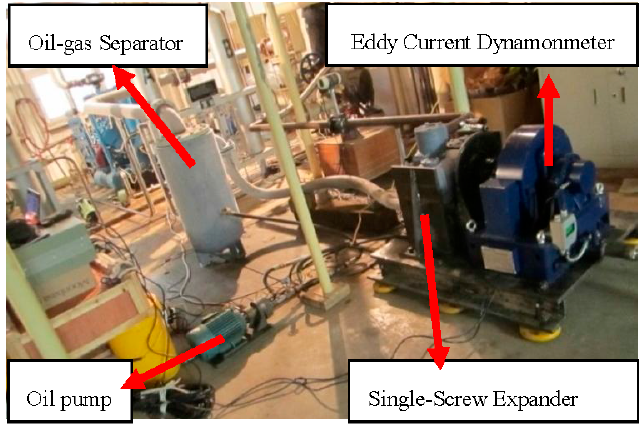
Figure 5. Experimental platform.